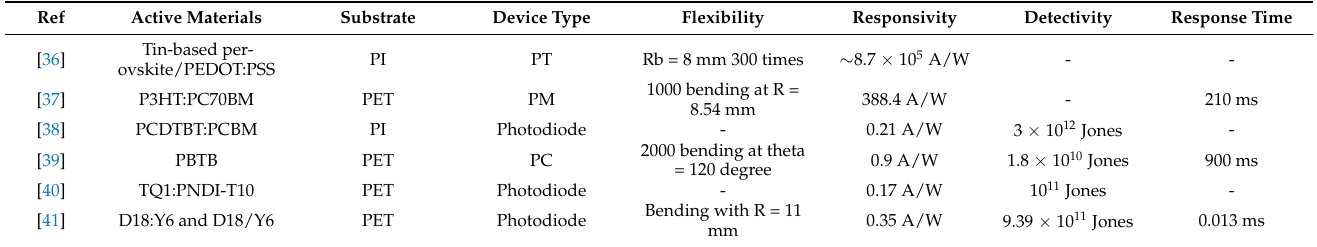
Table 1. A summary of recent progress made in the development of Flexible